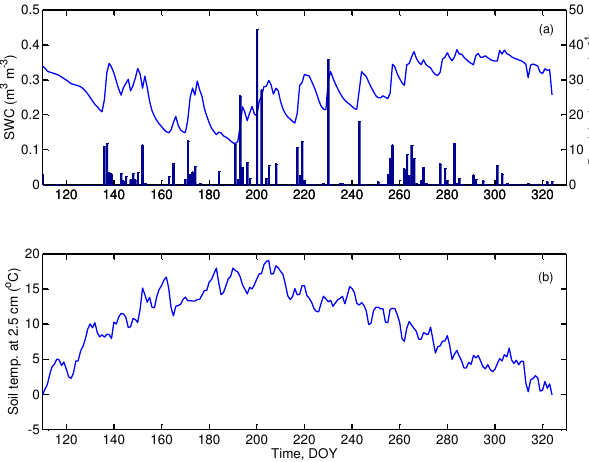
Figure 2. Soil water content (SWC) at 2.5cm depth and precipita- tion (a) and soil temperature at 2.5cm depth (b) during the mea- surement